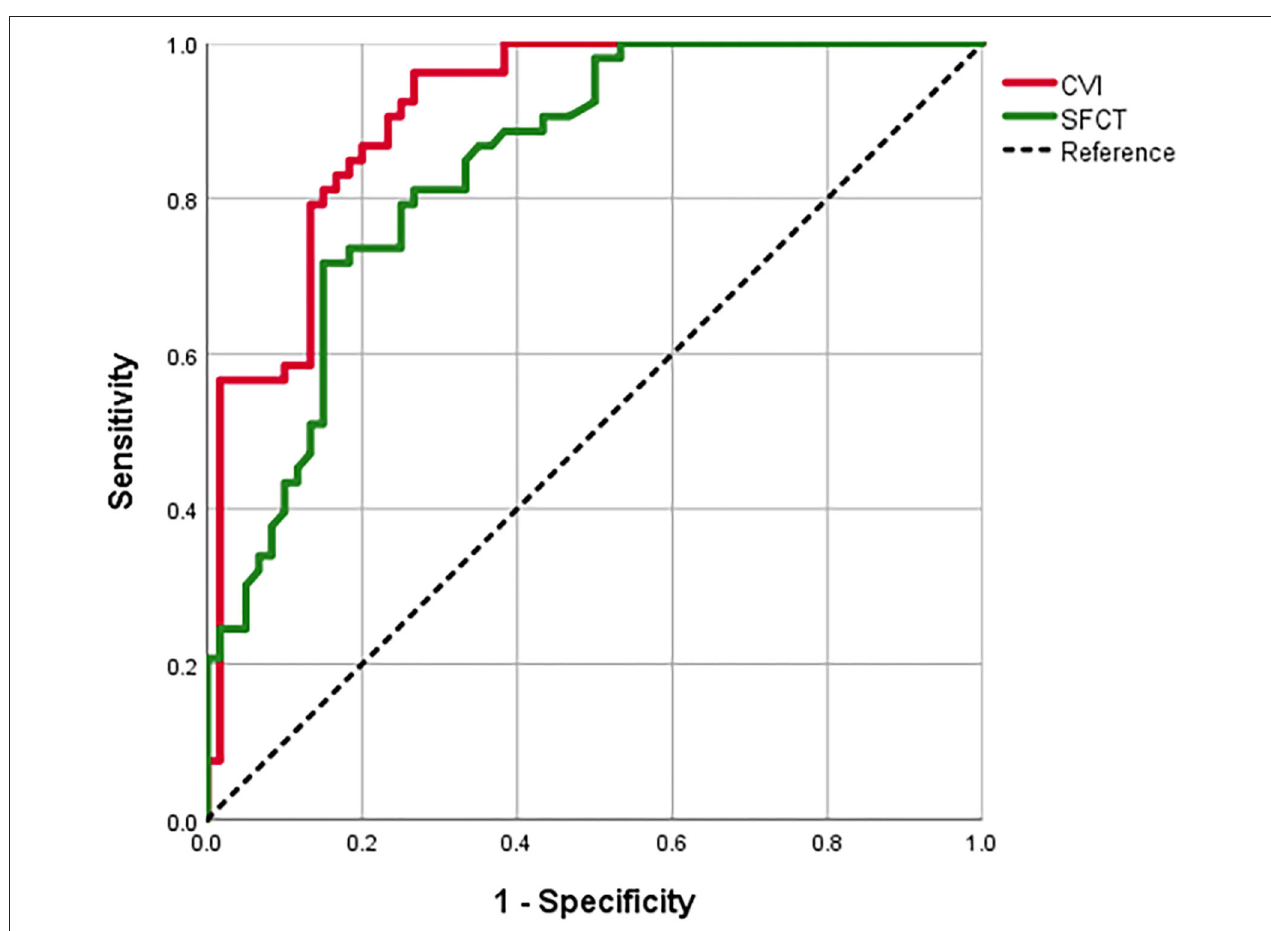
FIGURE 3 | The receiver operating characteristic (ROC) curves for the SFCT and the CVI to separate eyes with MG from control eyes with POCG.